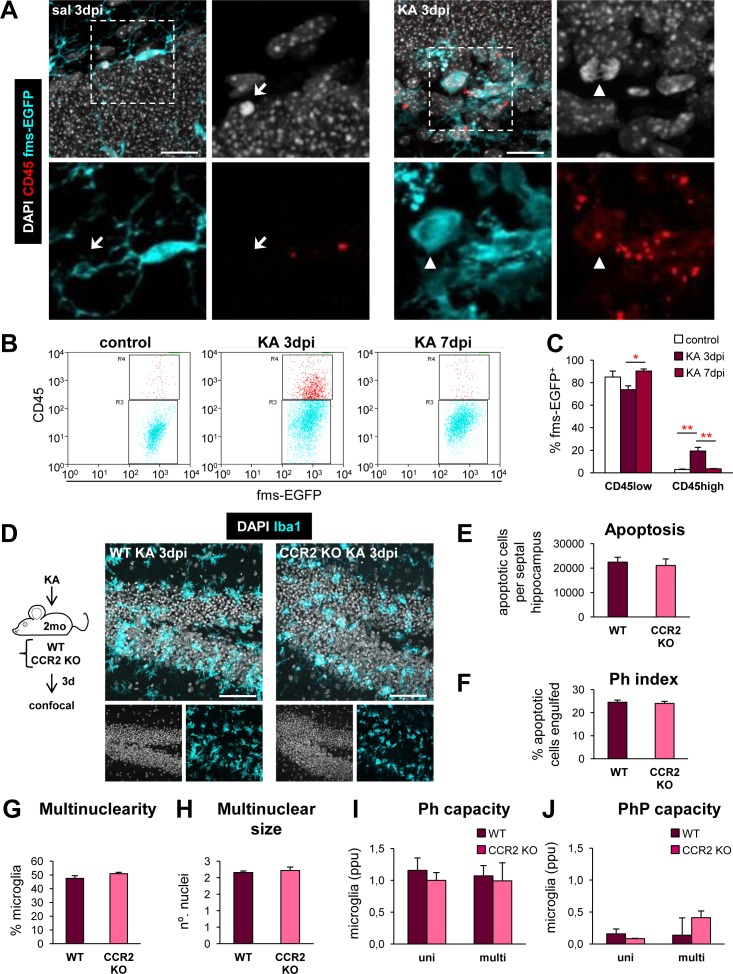
Microglial phagocytosis impairment is unrelated to monocytes.(A) CD45 staining in saline- and KA-injected mice at 3 dpi. Cell nuclei are shown in white (DAPI), microglia in cyan (fms-EGFP), and CD45 in red. In control mice, the expression of CD45 was dim, showing diffuse cytoplasmic inclusions within microglia. A CD45+ cell is shown engulfing an apoptotic cell (arrow, enlarged). In KA mice, CD45 had a higher and more widespread expression in all microglial cells, including a dividing cell (arrowhead, enlarged). A clear distinction between CD45high and CD45low cells was not evident. (B) Flow cytometry analysis of the expression of CD45 in fms-EGFP+ hippocampal cells from control and KA-treated mice. Gates for CD45low (cyan) and CD45high (red) were defined based on the distribution of the fms-EGFP+ cells in control (not injected) mice. 3 dpi after the KA injection, more cells were found in the CD45high gate, although the fms-EGFP+ cells were in fact distributed along a continuum of CD45 expression, all of them with higher expression than control mice. At 7 dpi, the expression of CD45 returned to basal levels. The gating strategy is shown in S4B Fig. (C) Percentage of fms-EGFP+ cells that expressed low or high levels of CD45 in control or KA-treated mice determined by flow cytometry (n = 4 per group). (D) Experimental design and representative confocal z-stacks of the hippocampus of CCR2-/- (CCR2 KO) mice and control WTs (C57BL/6) injected with KA (3 dpi). No obvious differences in the status epilepticus, neuronal damage, microglial morphology, nor in the DG volume (S4C Fig), or neutrophil infiltration were found (S4D and S4E Fig). (E) Number of apoptotic (pyknotic/karyorrhectic) in the septal DG in WT and CCR2 KO mice 3 dpi after KA (n = 4 per group). (F) Ph index in the septal DG (in % of apoptotic cells) in WT and CCR2-/- mice 3 dpi after KA. (G) Multinuclearity in WT and CCR2-/- mice. (H) Size of multinucleated cells in WT and CCR2-/- mice. (I) Weighted Ph capacity in WT and CCR2-/- mice. Note that the Ph capacity is higher than in our previous time course (Fig 4H), reflecting an increased number of apoptotic cells in this experiment compared to the previous one, possibly because it was performed in different animal facilities. (J) Weighted PhP (phagoptosis) capacity in the septal DG in WT and CCR2-/- mice. Data are shown as mean ± SEM. * indicates p < 0.05, ** indicates p < 0.01, and *** indicates p < 0.001 by Holm-Sidak posthoc test, after one-way ANOVA was significant at p < 0.05; only significant interactions are shown. Scale bars = 20 μm (A), 50 μm (D); z = 14.7 μm (A), 12.6 μm (D). Underlying data is shown in S1 Data.